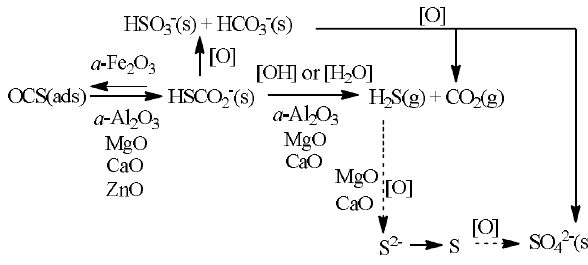
Scheme 1. Reaction pathway for OCS on different mineral oxides.